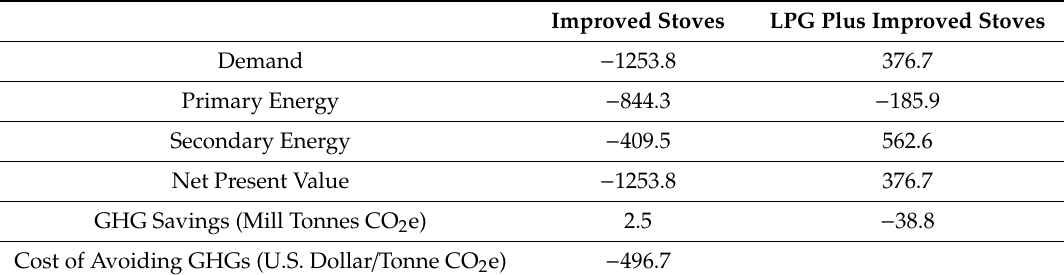
Table 2. Cumulative Costs and Benefits of an Improved Stoves Strategy in Honduras: 2016–2030. Relative to Scenario: BAU. Discounted at 5.0% to year 2016. (Units: Million 2016 U.S.